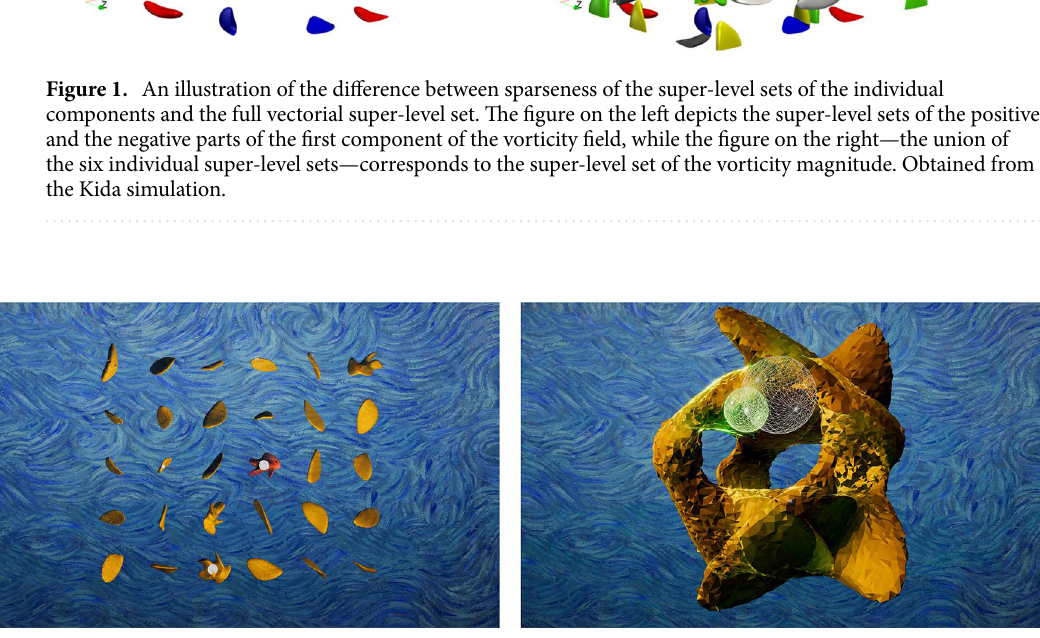
Figure 2. Screen captures from the Turbulence computational citizen science game showing first the selection of the RIVs and second, moving a sphere inside an individual RIV. Recall, the radius of the largest sphere that can fit inside each individual RIV represents the scale of sparseness.